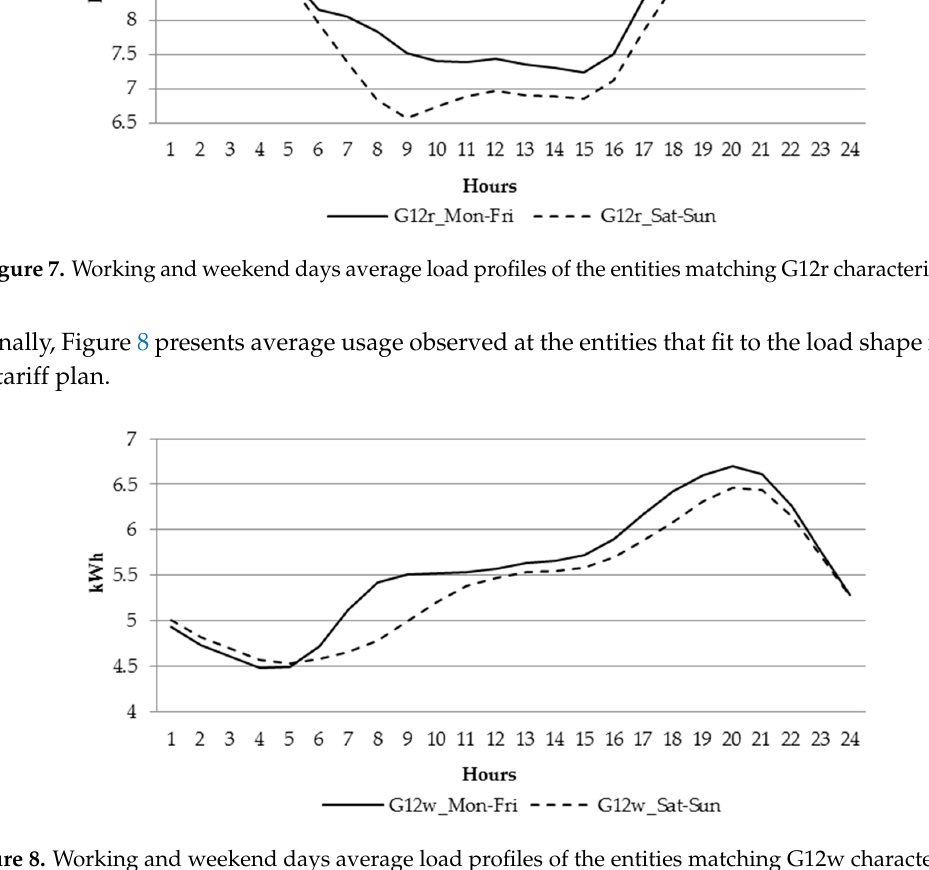
Figure 8. Working and weekend days average load profiles of the entities matching G12w characteristics.